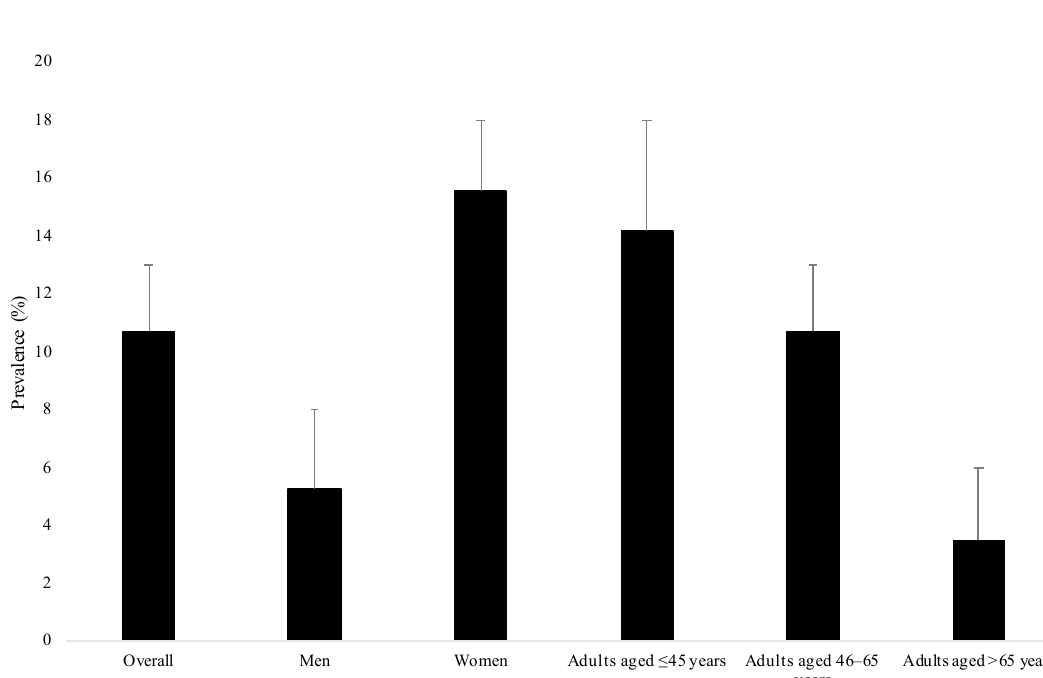
Figure 1. Flow chart of study participants.